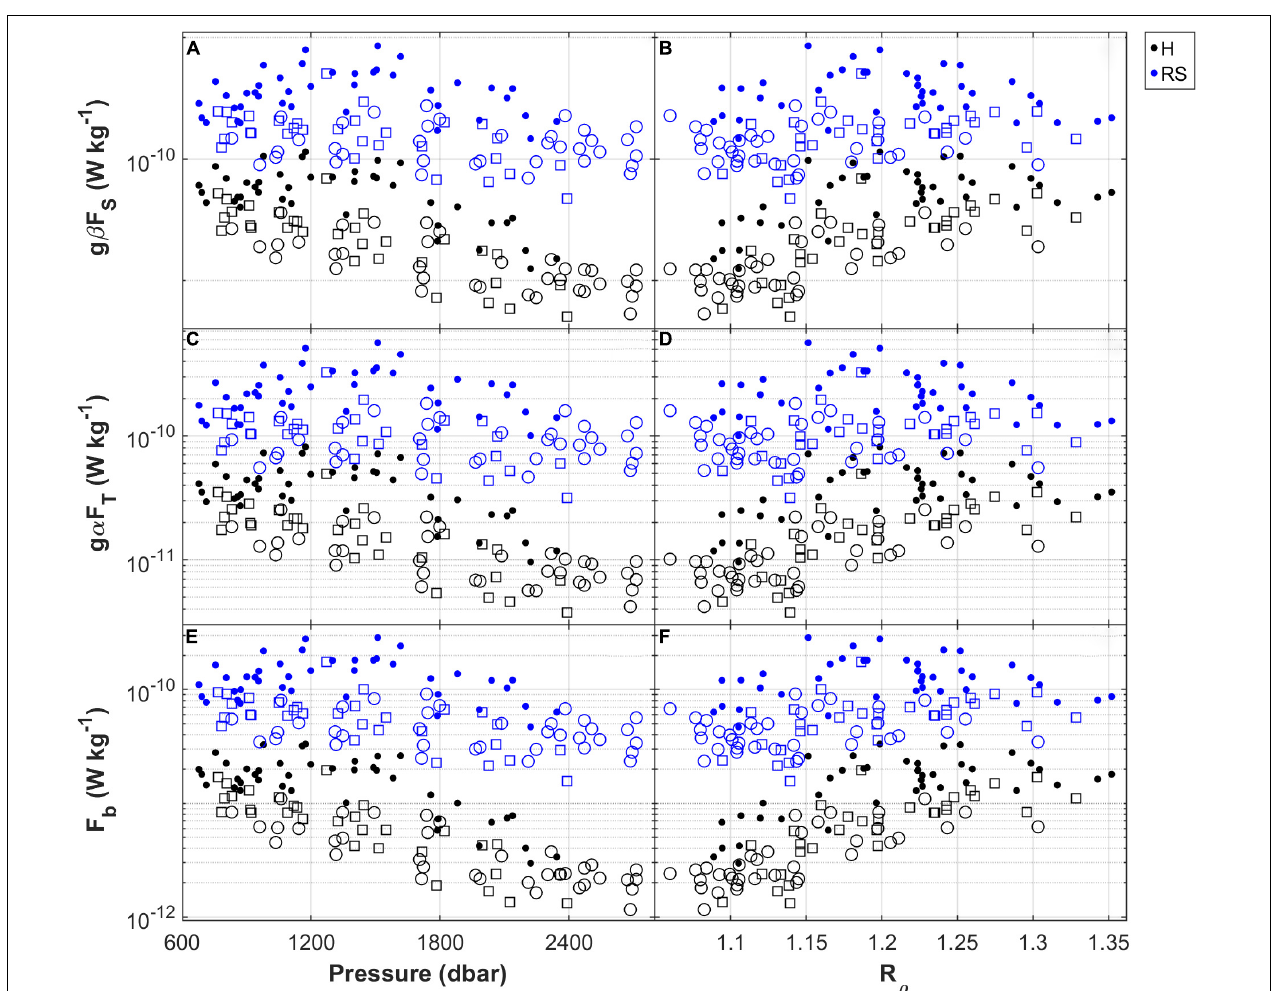
FIGURE 9 | (A,C,E) The salt and heat contributions ( g β F S and g α F T ) to the buoyancy flux and the net buoyancy flux ( F b ) versus pressure. (B,D,F) The same, but this time versus the density ratio ( R ρ ) instead of pressure. Sharp, slope and steppy interfaces are represented by a black circle, a white circle and a white square, respectively. In the legend, H and RS refer to H88 and RS12, respectively. The axes expressing the fluxes are set to the logarithmic